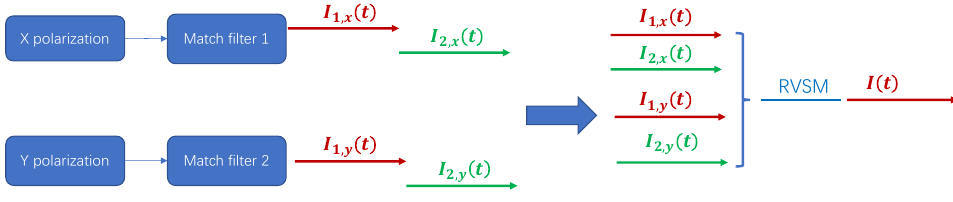
(𝑡) , 𝐼 (𝑡) ; we first delay the 𝐼 1,𝑥 1,𝑦